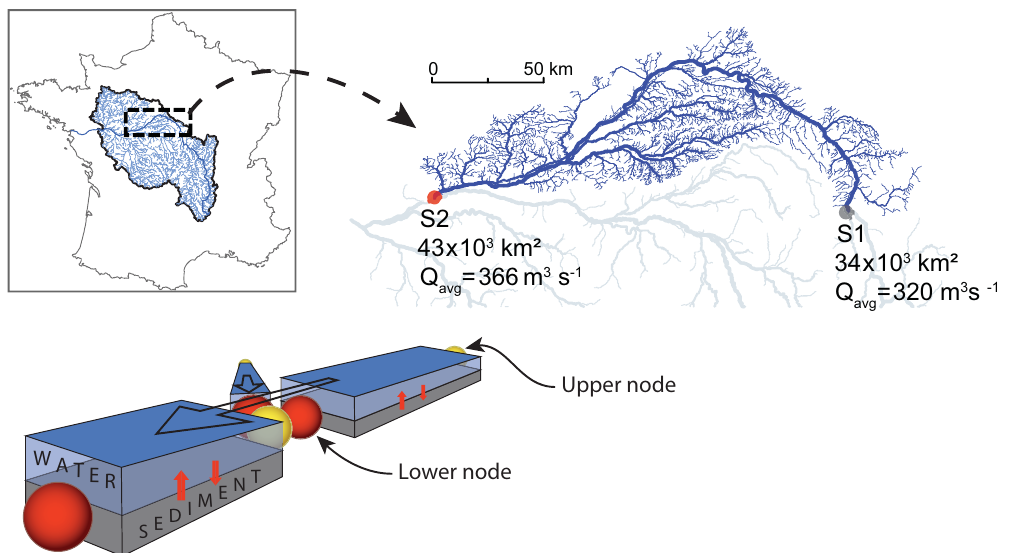
Figure 1. Study area, the Middle Loire River Corridor sub-catchment defined between stations S1 and S2, and network topology concept used in the